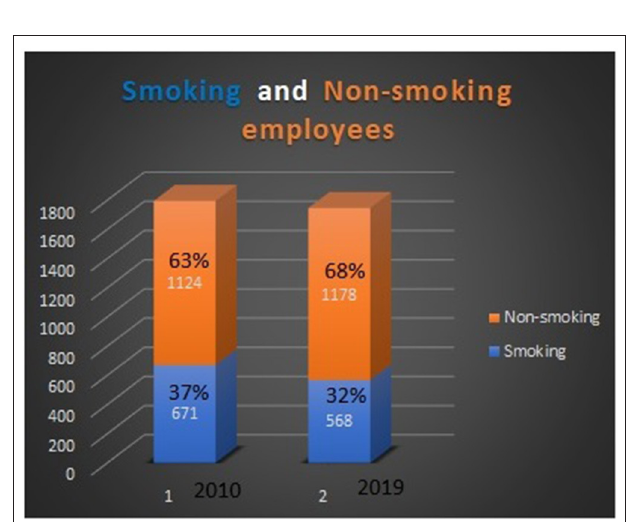
FIGURE 2 | Smoking vs. non-smoking employees in 2010 and